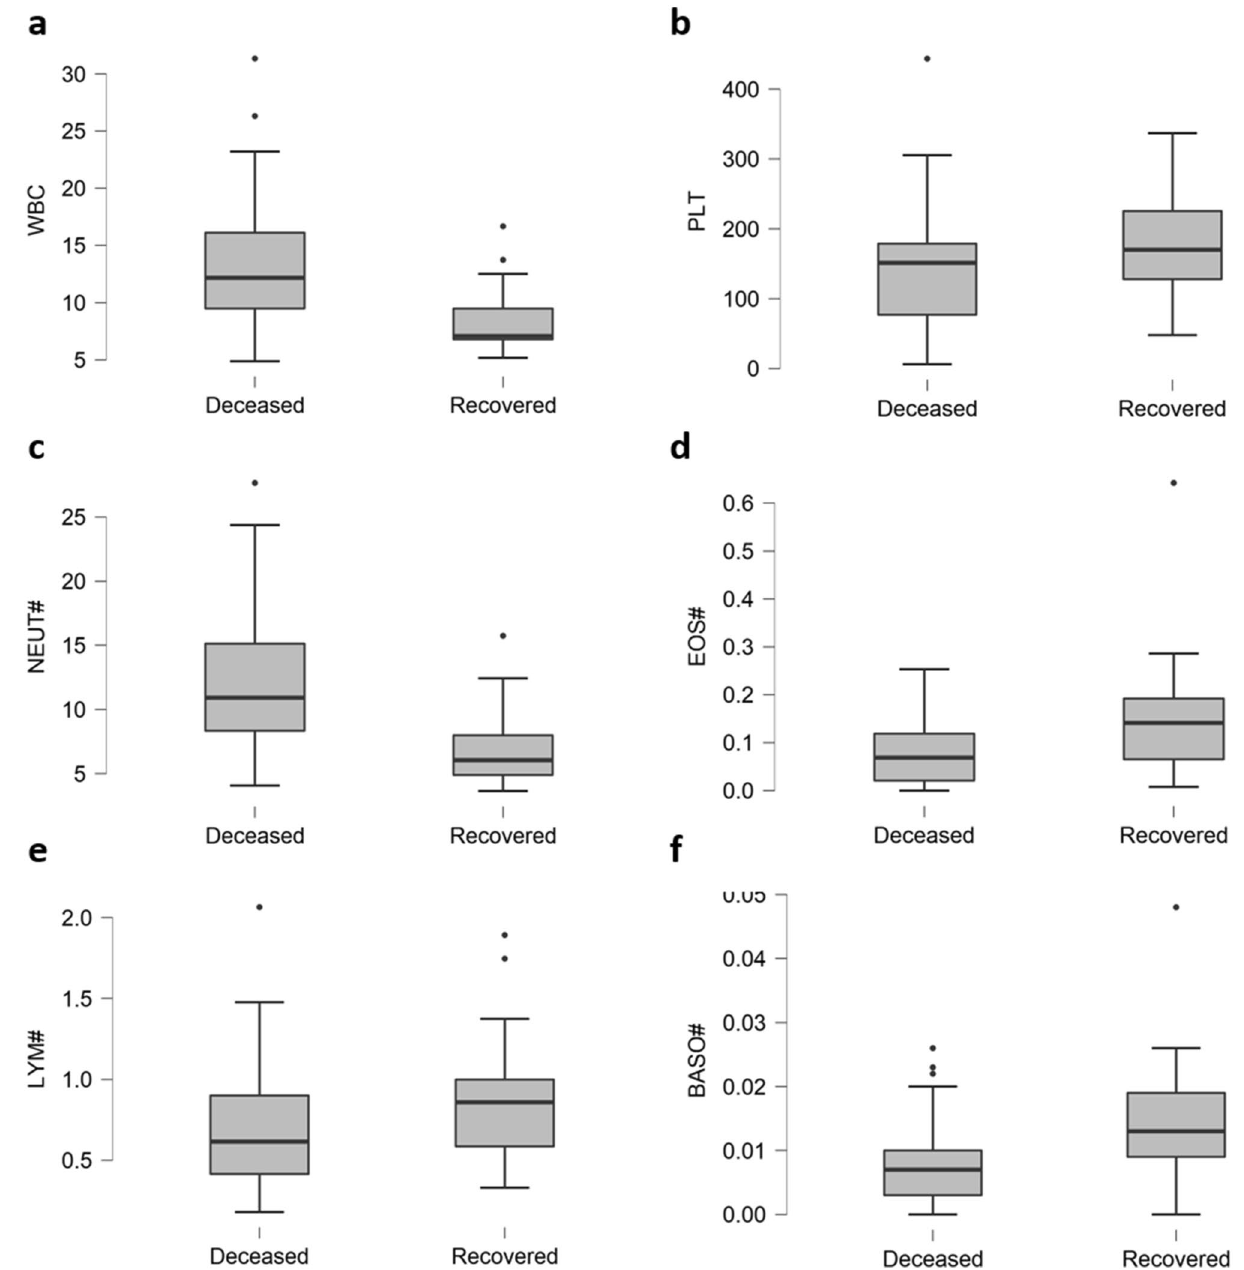
Figure 1. Boxplots depicting comparison of 6 hemolymphatic parameters of deceased and recovered patients. Elevated levels of WBC ( a ), NEUT# ( c ), LYM# ( e ), while decreased levels of PLT ( b ), EOS# ( d ) and BASO# ( f ) is common in deceased